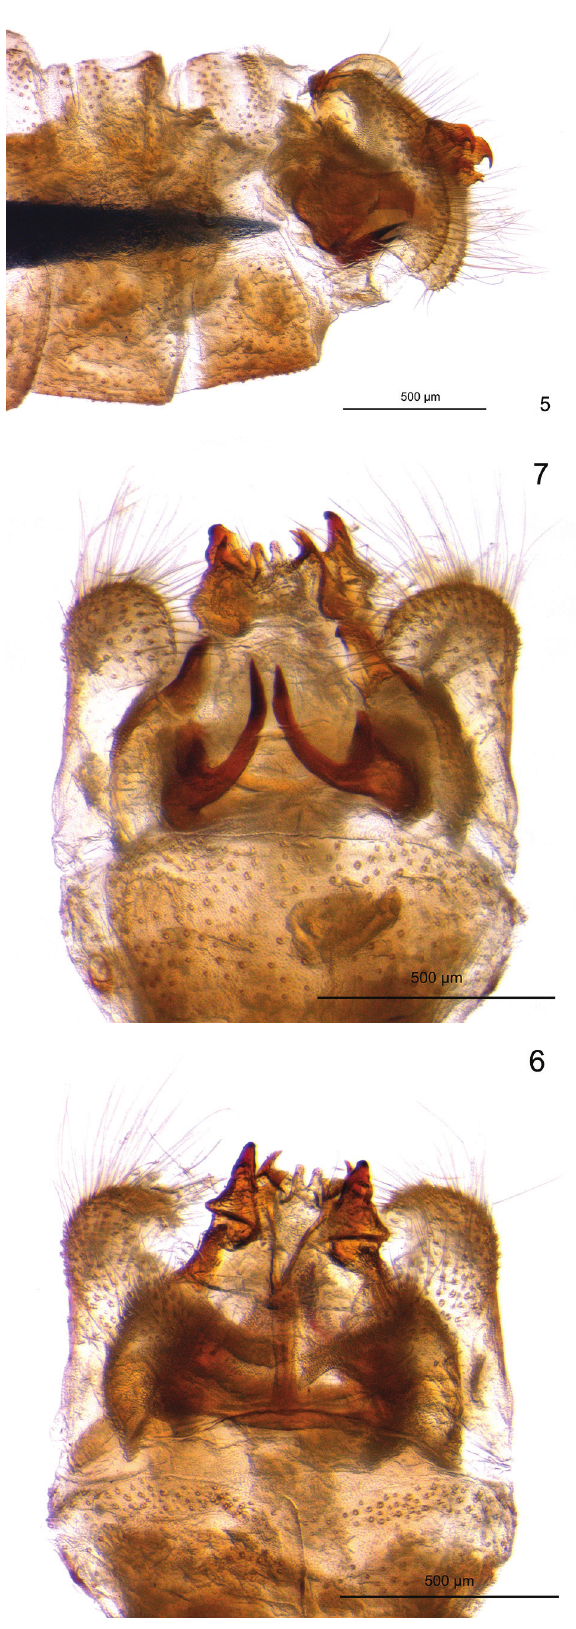
Figures 9–10. Dilar turcicus Hagen, holotype female of Dilar corcyraeus Navás (NHMW, Vienna). 9. Habitus (The abdomen is preserved in a vial in glycerine), dorsal view; 10.